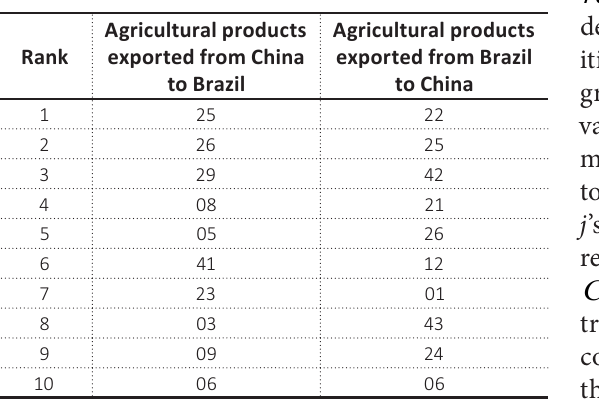
Table 3. Top ten agricultural products traded between China and Brazil from 2010 to 2019